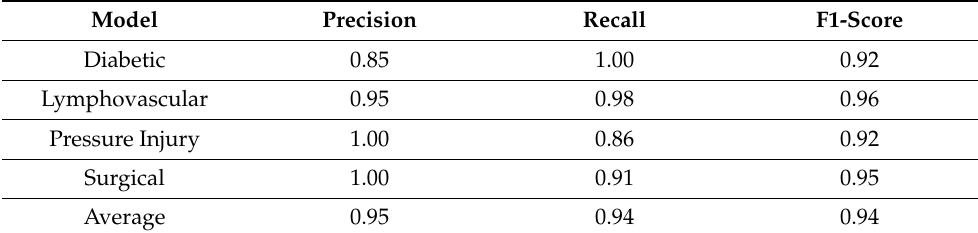
Table 2. Classification performance evaluation of the proposed